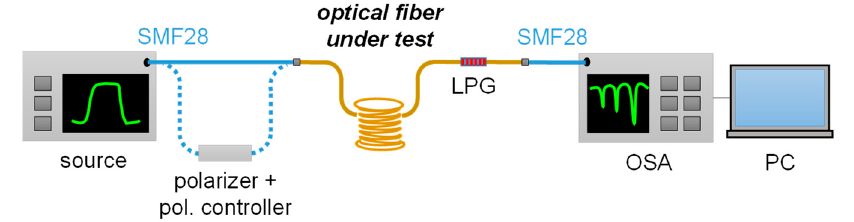
Figure 2. Optoelectronic setup for the measurement of Long Period Grating (LPG) spectrum.